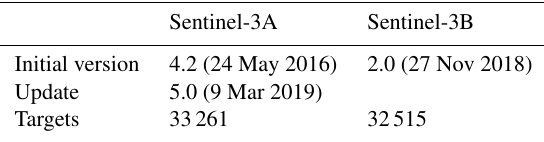
Table 1. OLTC versions considered in this study. The number of targets corresponds to the latest version and can be visualized and found on https://www.altimetry-hydro.eu/ (last access: 15 Jan- uary